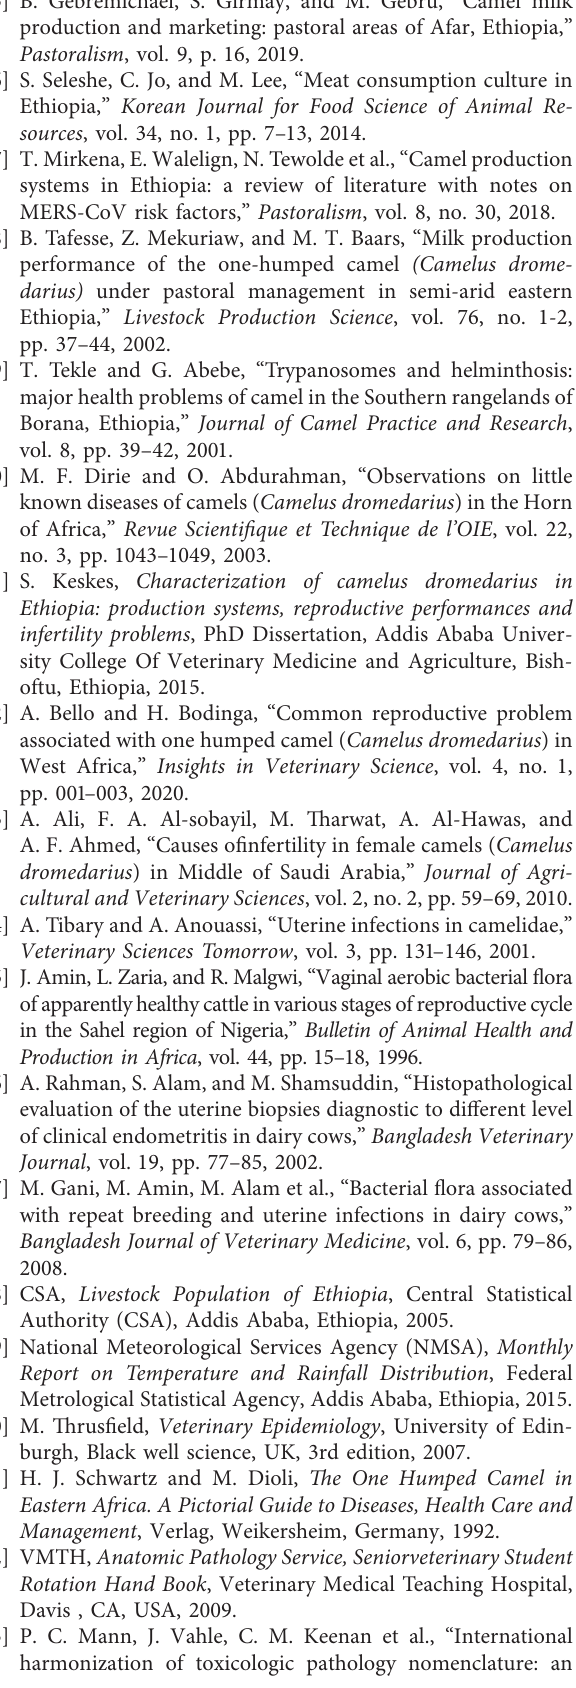
Figure 2021-1: ovarian cysts: the paraovarian cysts which are epithelium-lined fluid-filled cysts. Figure 2021-2: hydro- salpinx and salpingitis: in hydrosalpinx cases, the oviduct (fallopian tube) was filled with a watery fluid (edematous), and the inflammatory condition (salpingitis) was appreci- ated with a hyperemic inflammatory region (reddish). Figure 2021-3: endometritis: inflammatory condition of the inner lining of the uterus which was grossly observed with a hyperemic uterus (reddish in colour) with few whitish spots and enlarged size. ( Supplementary Materials